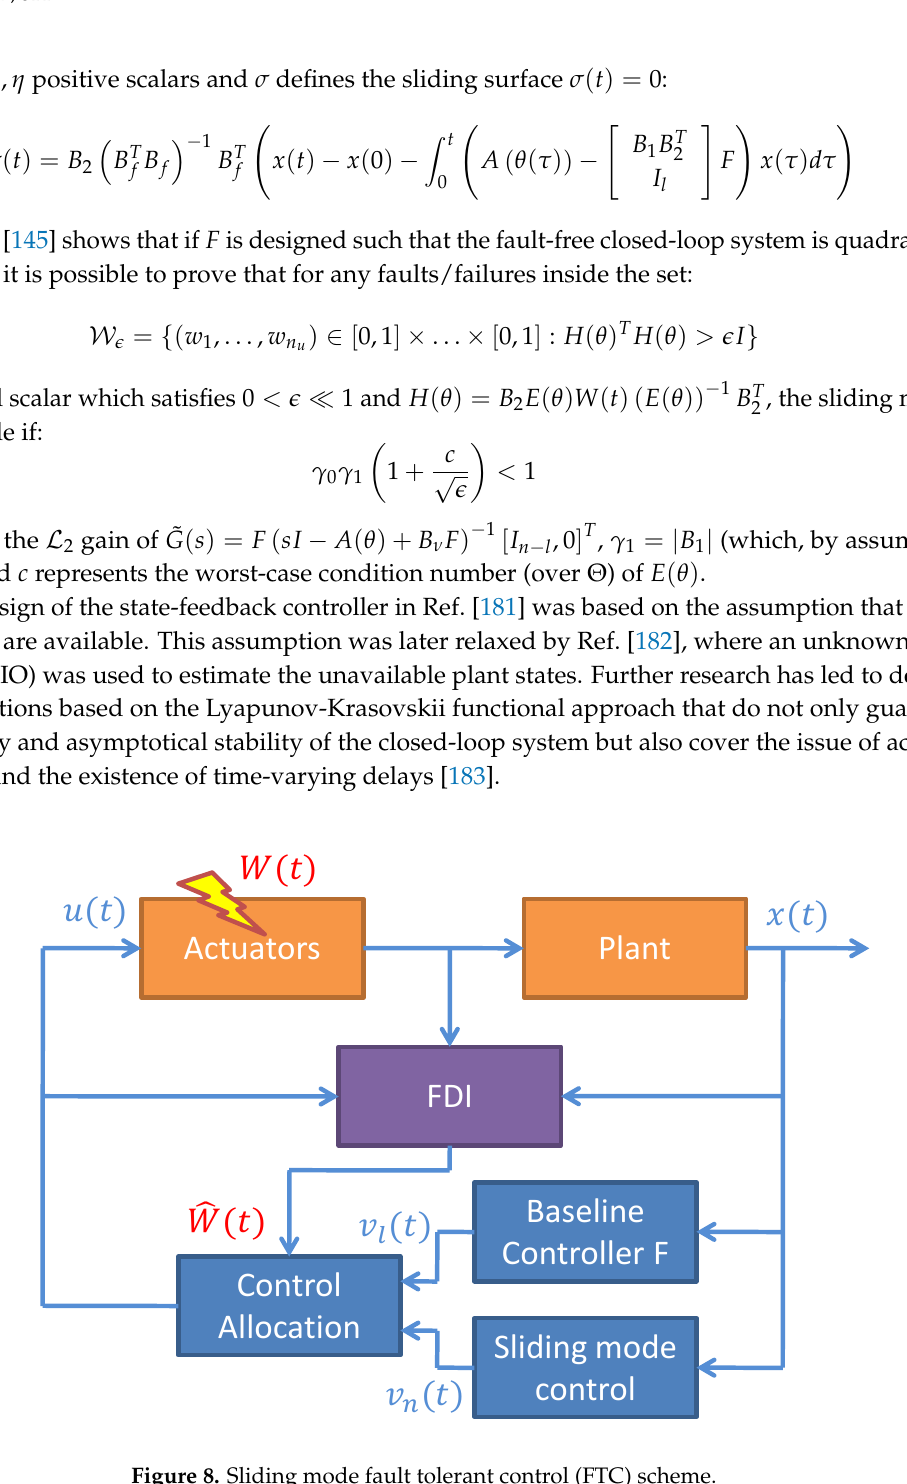
Figure 8. Sliding mode fault tolerant control (FTC)